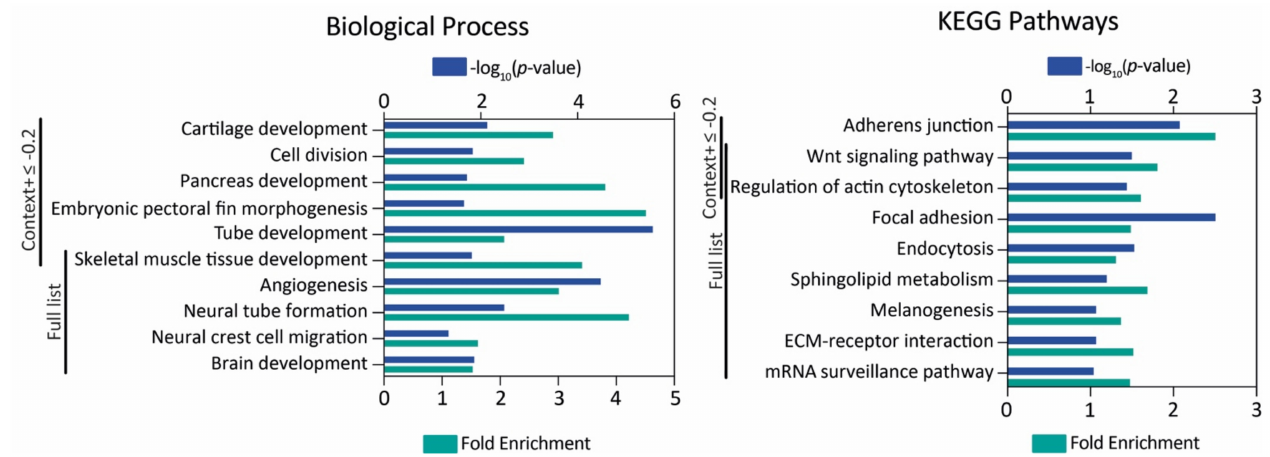
Figure 2. MiR-145 zebrafish target gene analysis. Gene Ontology and KEGG pathway enrichment analysis of genes with context+ score under − 0.2 and the full list. The -log 10 ( p -value) and fold enrichment of selected biological process terms ( left ) and KEGG pathways ( right ) are